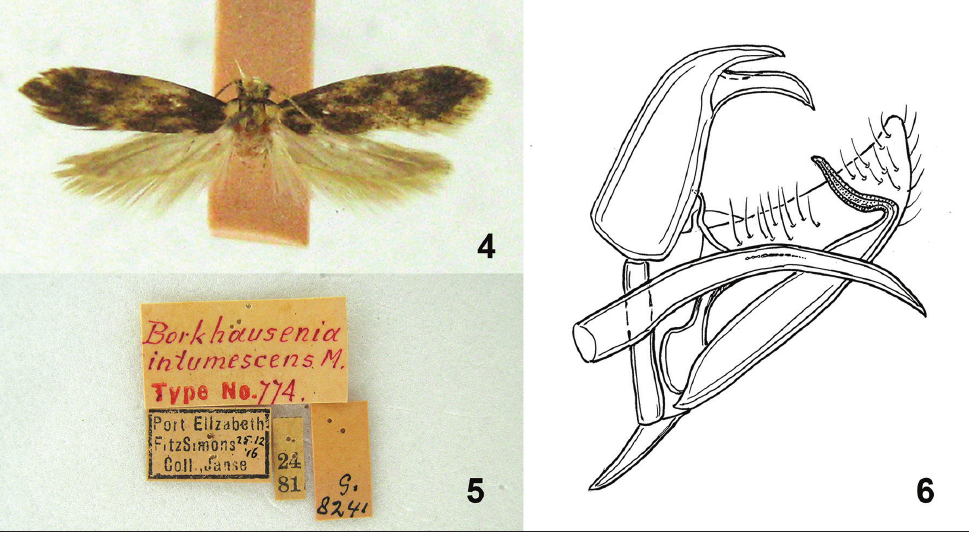
shorter than segment 2, with fuscous base and apex. Thorax creamy ochreous. Forewing elongate, narrow, creamy ochreous with extensive fuscous patches, sometimes mixed creamy ochreous, one patch at base extending to one-third on costa, and to three-fifths on dorsum with irregular outer margin, one in terminal quarter of wing and a small elongate patch along costa at middle; usual - ly three dark fuscous round spots in mid-line, the first and third usually touching the basal and terminal dark patches respectively, the middle spot nearer the costa than the other two, a